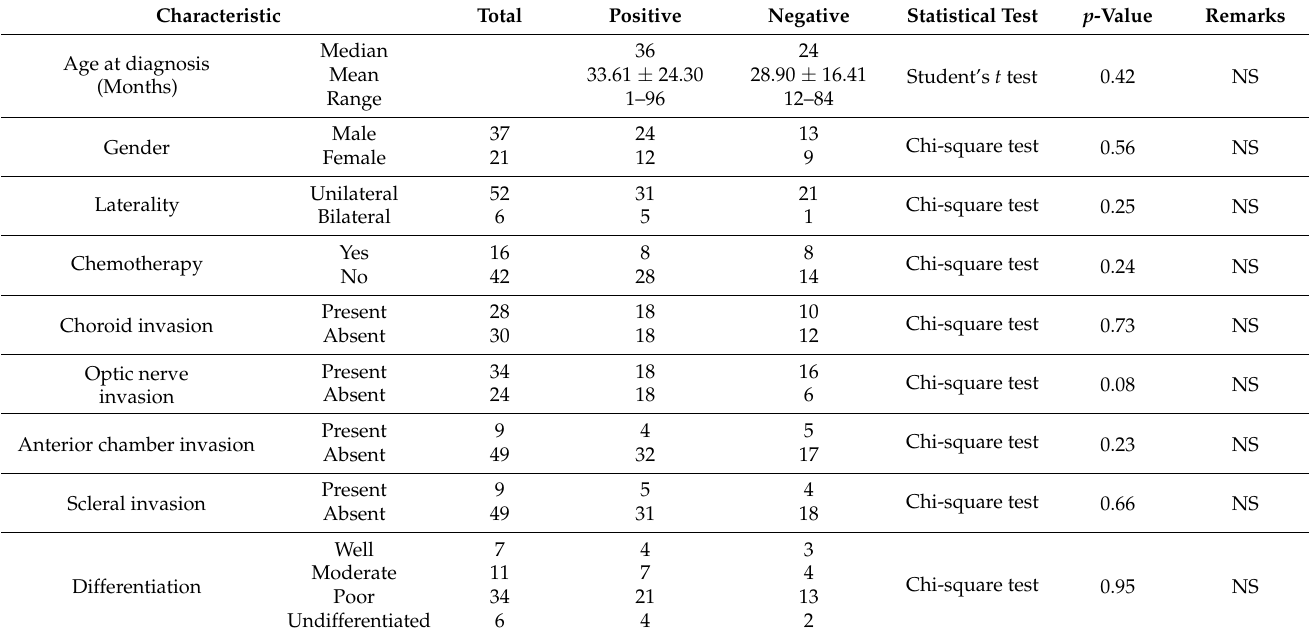
Table 1. Correlation analysis of MYCN expression with demographic and histological characteristics of RB patients. Characteristic Total Positive Negative Statistical Test p